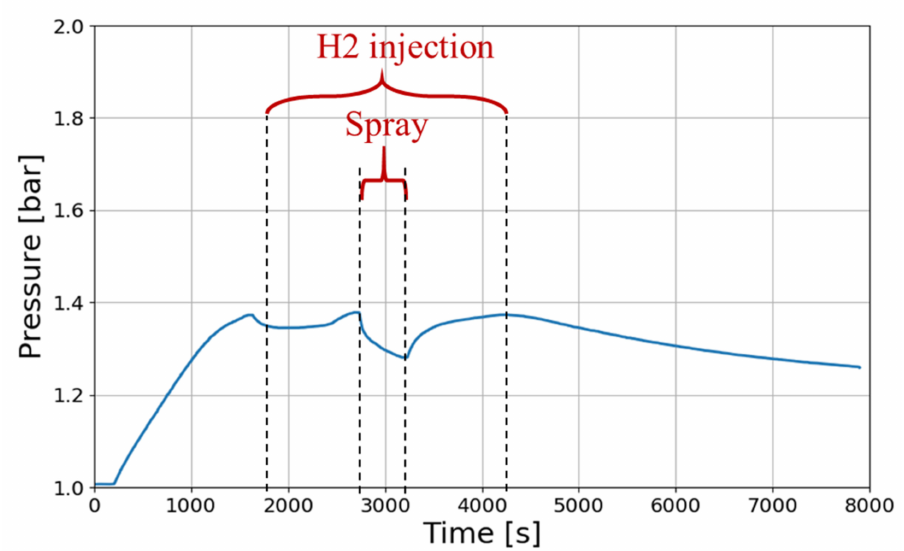
Figure 20. Time variation of the vessel pressure during the SSP4 test.